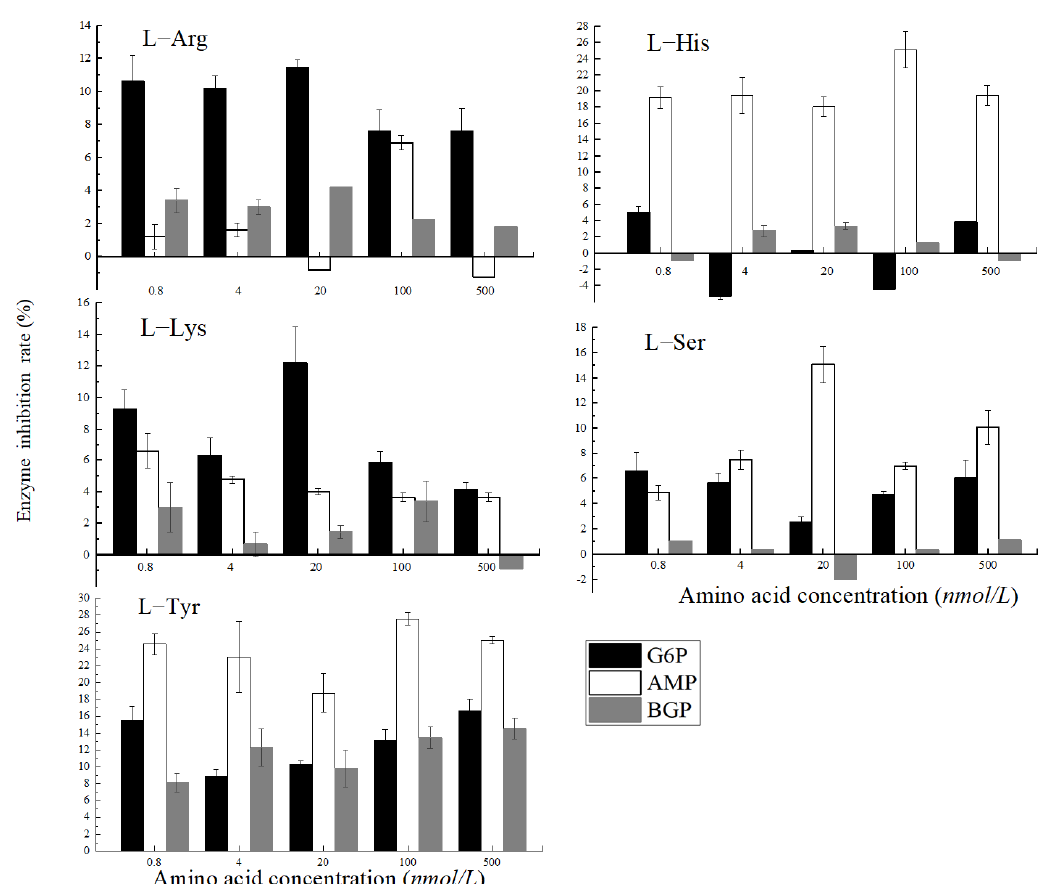
Figure 4. Effects of amino acids L-Tyr, L-His, L-Arg, L-Lys, and L-Ser on PhoA mineralization of organic phosphorus.